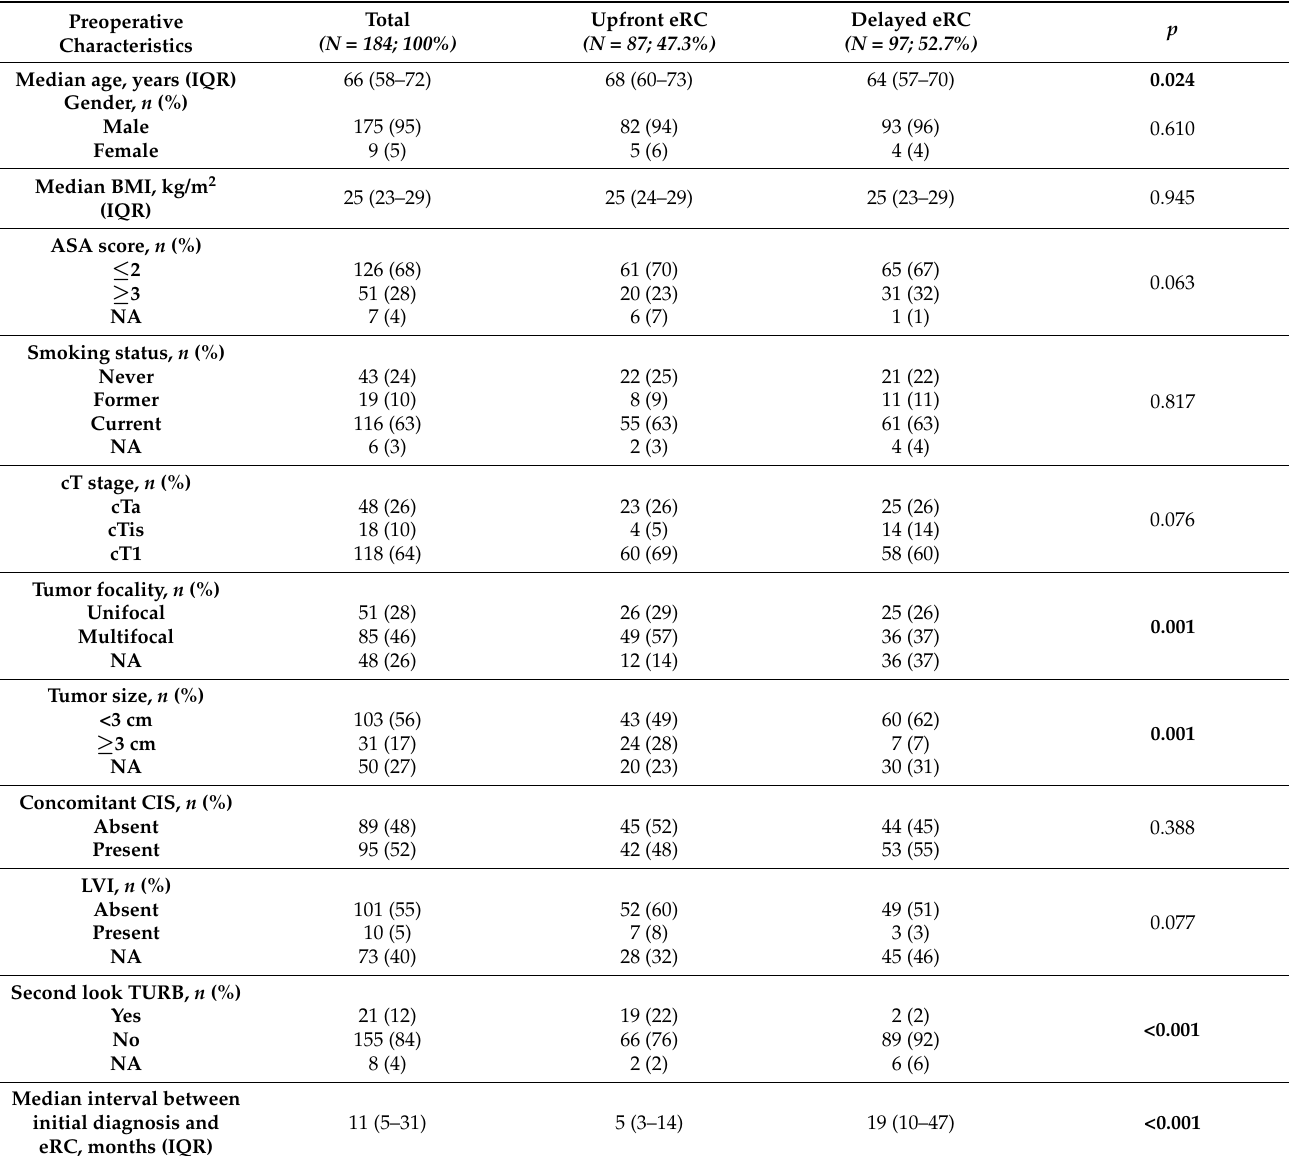
Table 1. Baseline characteristics of included patients treated with upfront or delayed eRC for HR- NMIBC. Bold: It is a significant